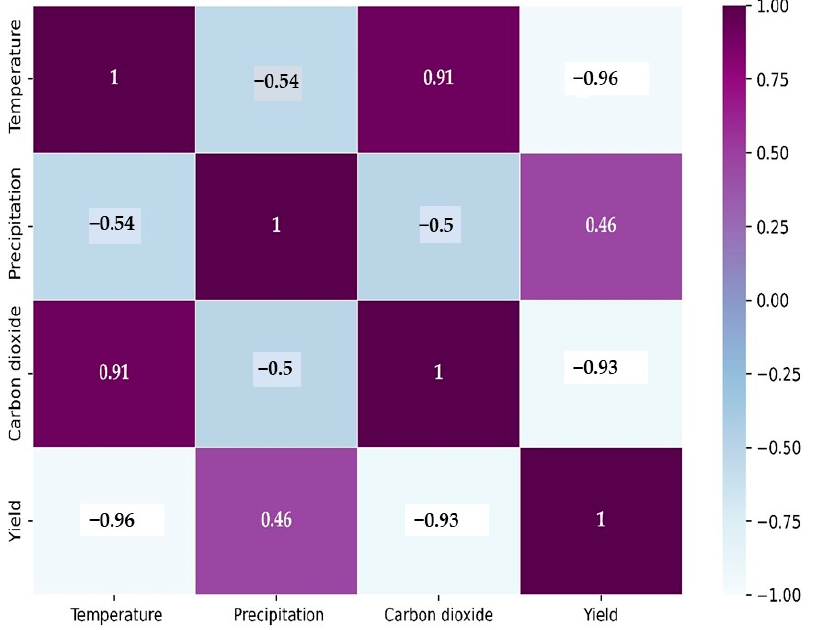
Figure 8. Pearson correlation coefficient heatmap of maize yield with temperature, precipitation, and CO 2 concentration under baseline, near, mid and end century (RCP4.5 and RCP8.5) scenarios.